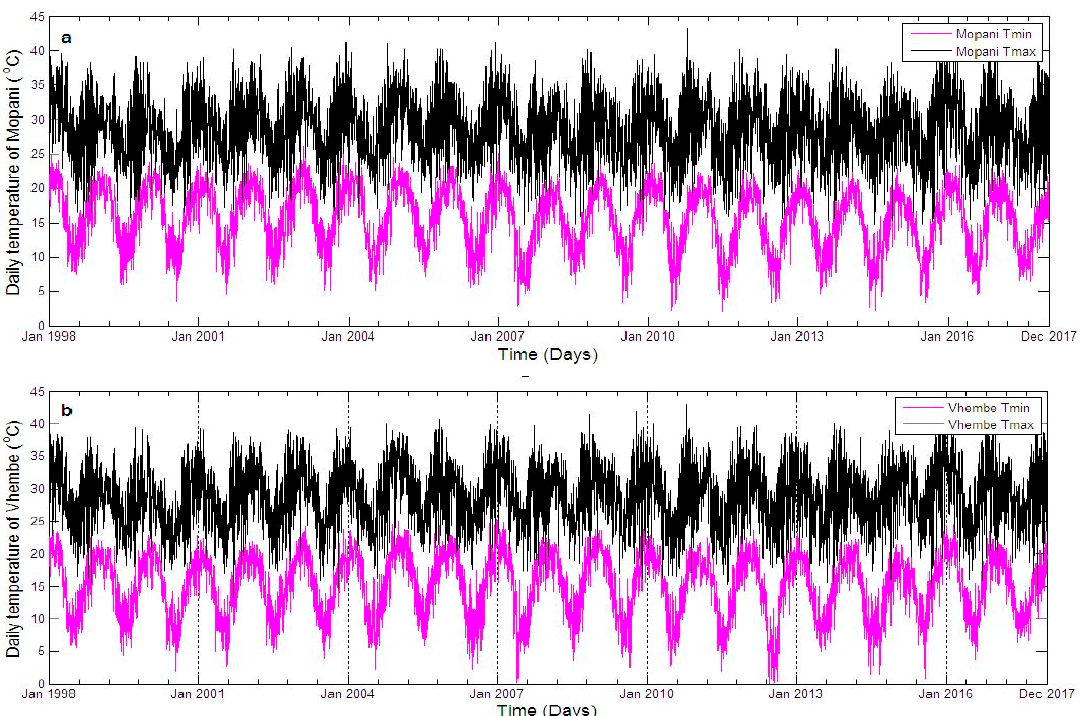
Figure 2. Time series of daily temperatures over calibration period showing the ( a ) daily maximum and minimum temperature of Mopani district municipality, ( b ) daily maximum and minimum temperature of Vhembe district municipality Limpopo province, South Africa from January 1998 to December 2017.